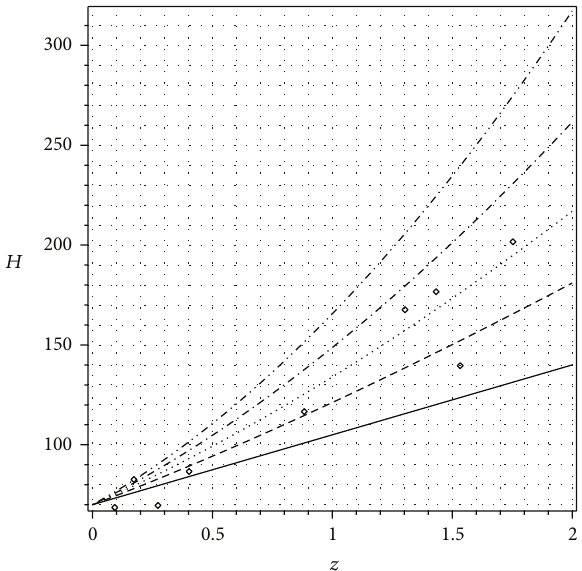
Figure 5: Hubble expansion parameter versus redshift in case of arbitrary 𝑛 and 𝛼 . We fix 𝑐 = 0.5 and 𝑙 = 1 (solid line), 𝑙 = 1.3 (dashed line), 𝑙 = 1.5 (dotted line), 𝑙 = 1.7 (dash dotted line), and 𝑙 = 1.9 (long dashed line); dots denote observational data